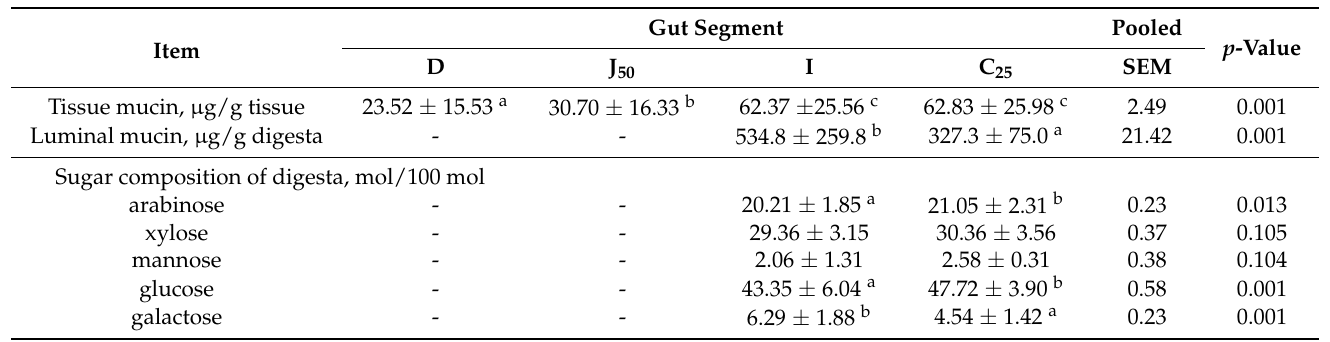
Table 6. Tissue and luminal mucin content ( µ g/g tissue or digesta) and digesta sugar composition (mol/100 mol) in gut segments of young